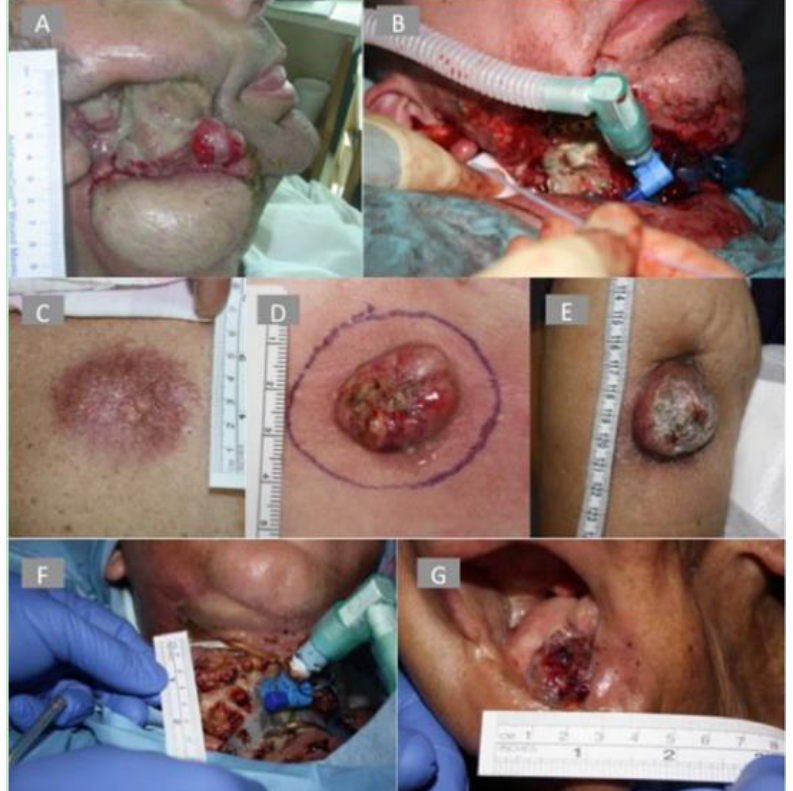
Figure 11. Sample of seven patients that presented with advanced and/or recurrent solid malignancies that were subjected to the PCI surface illumination protocol. ( A ) 56-year-old male with chondroblastic osteosarcoma in the right mandible. The patient has failed multiple surgical resections with reconstructions and multiple rounds of subsequent chemo-radiation. The patient was treated with 0.25 mg/kg TPCS 2a -induced PCI and had complete response of all the illuminated sarcoma of the R face. ( B ) 45-year-old male with squamous cell carcinoma of the neck with metastasis to the lungs and liver, who failed multiple conventional interventions. The patient was treated with 1.0 mg/kg TPCS 2a -induced PCI and had partial response ( C ) 61-year-old female with metastatic squamous cell carcinoma (SCC) to the torso (back). The primary malignancy was a tongue base SCC with metastasis to the cervical and axillary lymph nodes. She had multiple failed interventions to the primary site. The patient was treated with 0.5 mg/kg TPCS 2a -induced PCI and had complete response. ( D ) 46-year-old female with advanced metastatic ductal carcinoma to the torso (anterior) brain, spine, lungs and liver. The patient’s metastatic torso lesions were treated with 0.5 mg/kg TPCS 2a -induced PCI and had complete response. ( E ) 72-year-old female with metastatic (chemo-resistant) ductal carcinoma to the arm. The primary breast cancer also metastasised to the axillary and cervical lymph nodes. The patient’s metastatic arm lesion was treated with 1.0 mg/kg TPCS 2a -induced PCI and had partial response. ( F ) 35-year-old male with squamous cell carcinoma of the floor of mouth and neck. This patient failed surgery, chemo-radiation and photodynamic therapy. The cancer metastasised to the right lung and required pneumonectomy. The patient’s extensive disease was treated with 1.0 mg/kg TPCS 2a -induced PCI and had complete response of the treated areas. ( G ) 73-year-old male with oral squamous cell carcinoma. This patient failed multiple surgical interventions with reconstruction, as well as chemo-radiation. The patient’s extensive disease was treated with 0.5 mg/kg TPCS 2a -induced PCI and had complete response of the treated areas.